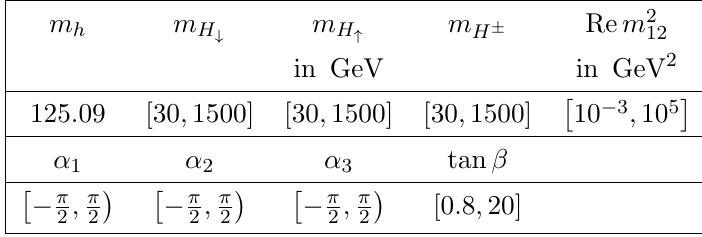
Table 4 . Parameter ranges for the C2HDM T1 input parameters used in ScannerS .